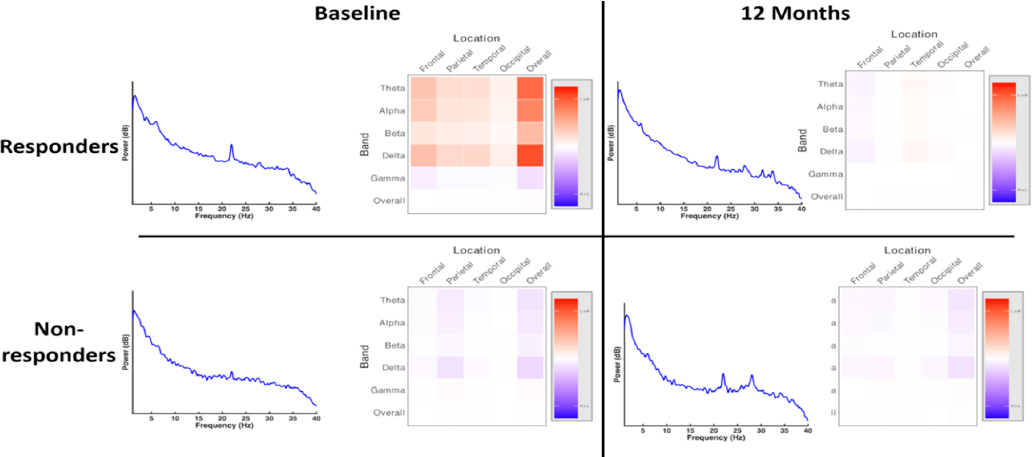
Figure 4. Power spectra and distribution of spectral power at baseline and at 12 months, responders and nonresponders. There were no statistically significant differences in the overall power spectrum between groups at baseline or at 12 months. There were no statistically significant differences in asymmetry measures between or within groups. Brain Sci. 2020 , 10 , x FOR PEER REVIEW